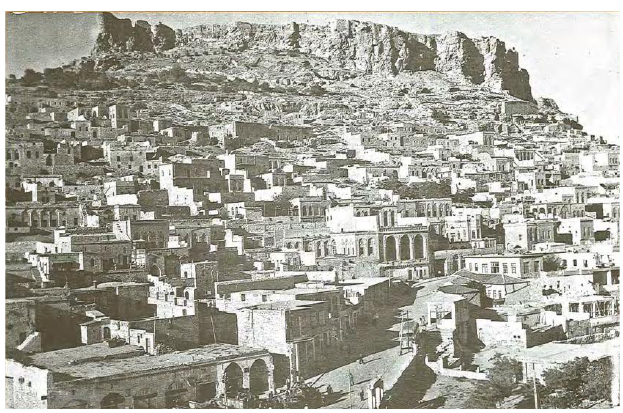
Fig. 8. View of the historical city of Mardin in 1932 [39]